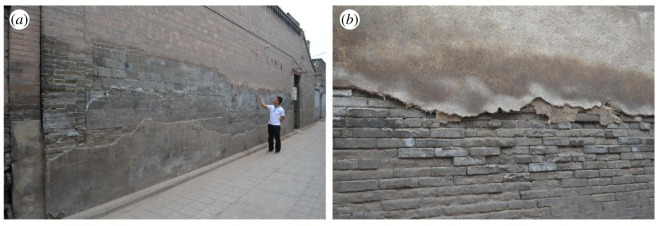
The practice of (a) smearing cement or (b) clay and plant fibres on the ancient brick in walls failed to prevent weathering of the ancient bricks.